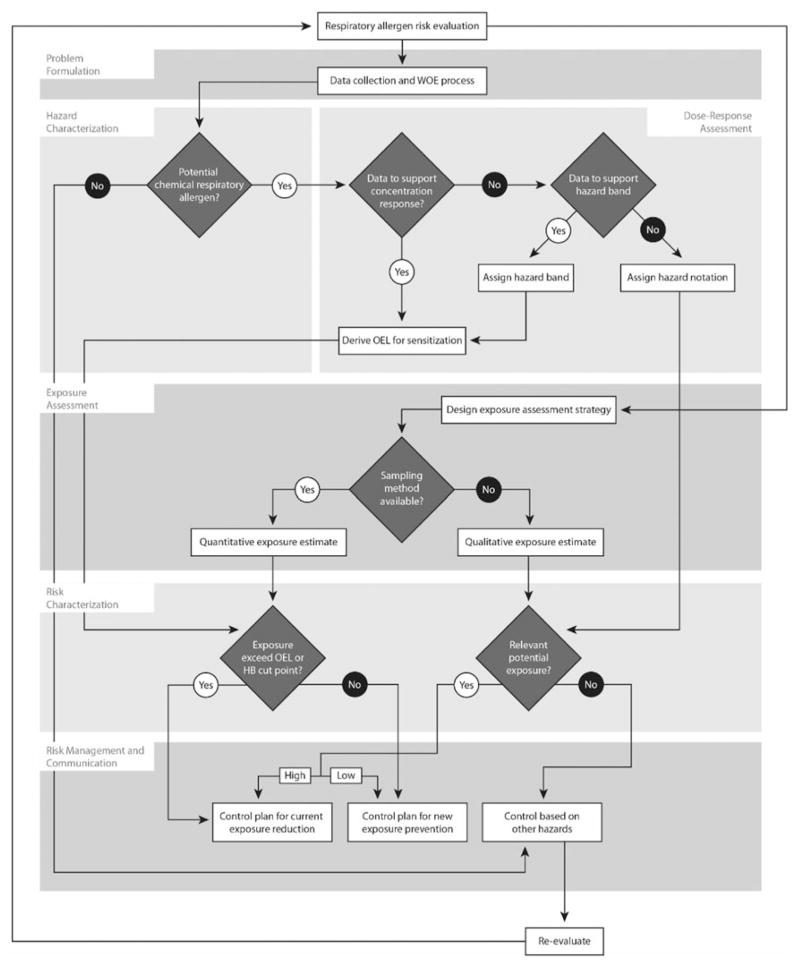
Consideration in assessing the health risks of potential chemical allergens. HB = hazard band; OEL = occupational exposure limit; WOE = weight of evidence.Theflowchart illustrates key consideration during the risk assessment of potential chemical allergens. On the basis of the risk assessment paradigm, the outlined process relies on a weight of evidence approach to critically evaluate available data. Included within the flowchart are options within each of the primary steps: hazard characterization, dose-response analysis, exposure assessment, risk characterization, and risk management and communication. These options allow for the evaluation of data, determining appropriate level of recommendation developed (i.e., hazard notation vs. occupational exposure limit), type of exposure assessment, and control technique.